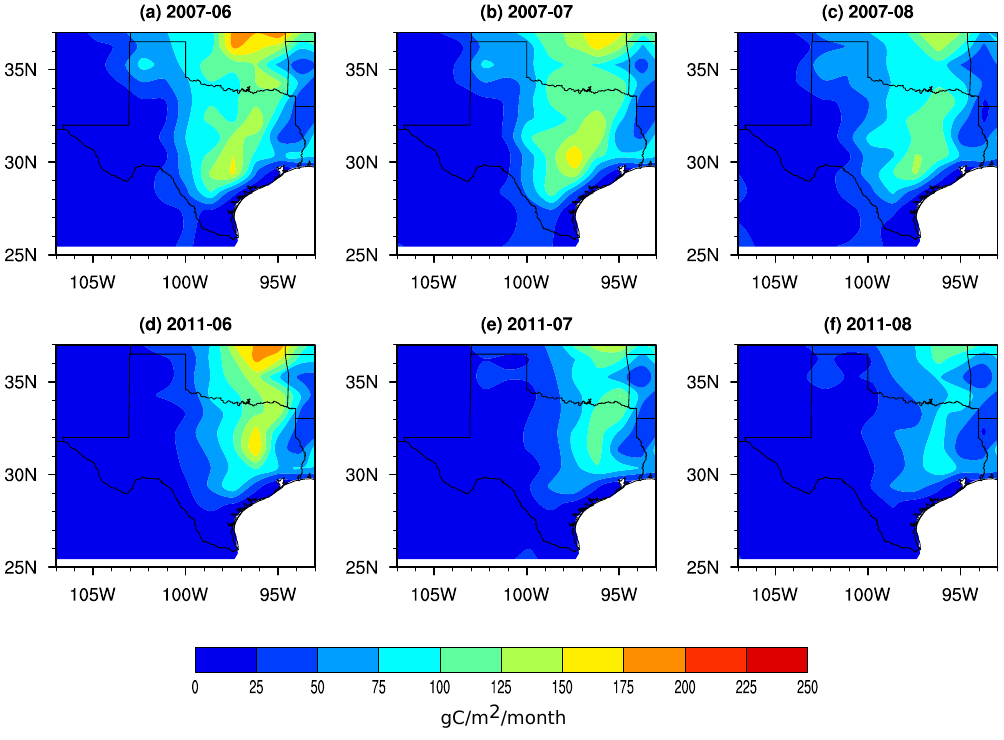
Figure 11. Spatial patterns of monthly total (C3/C4 grass plus C3 crop) predicted GPP based on SIF, precipitation and soil moisture over Texas in summer 2007, chosen as reference year ( a – c ), and summer 2011—drought year in Texas) ( d – f ).